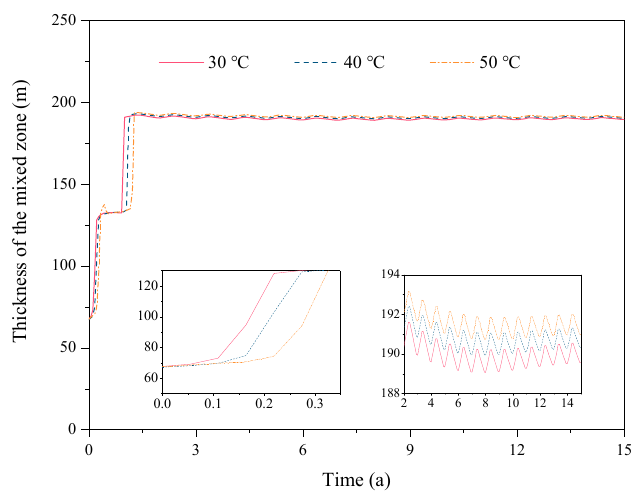
Figure 13. Reservoir average pressure for different temperature.